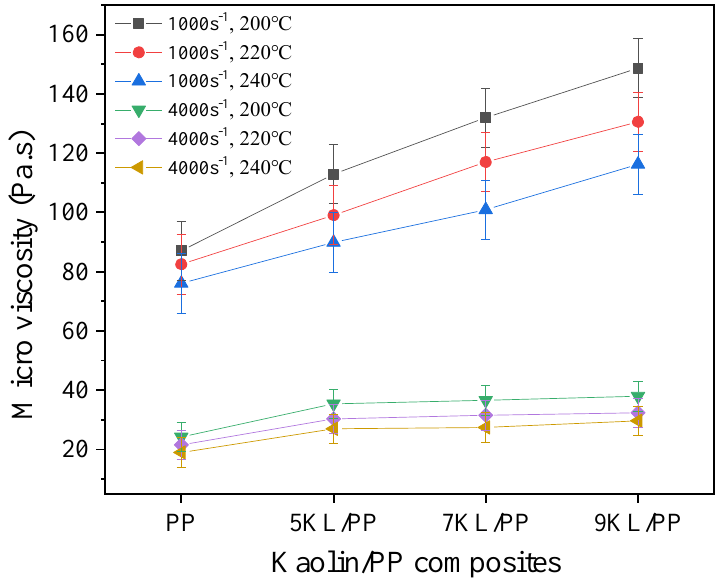
Figure 2. Effect of the kaolin content on the microviscosity of kaolin/PP composites.